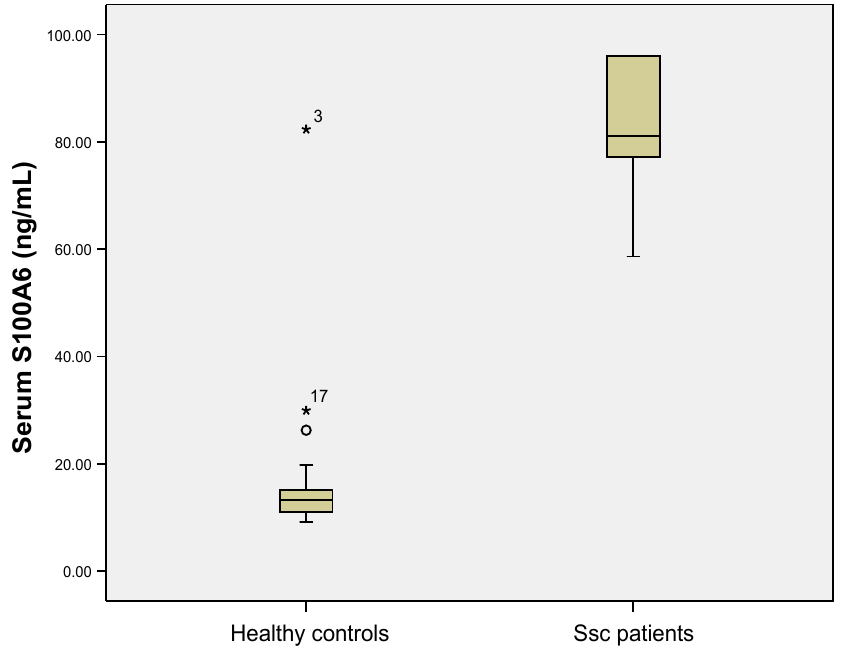
Figure 3. Serum S100A6 levels were higher in Ssc (systemic sclerosis) patients compared to healthy controls ( p < 0.001, Mann Whitney U test). The circle, stars and numbers in figure represent the patient ID in the database that are considered outliers by the statistical software used.